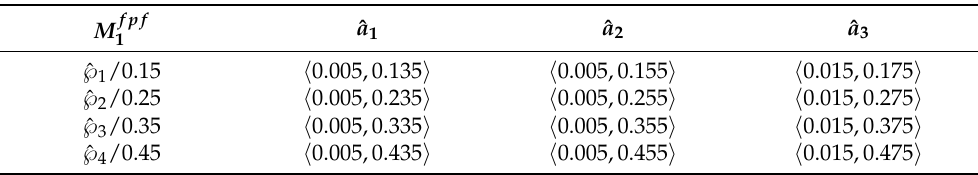
with entries in terms of CFNs. 1